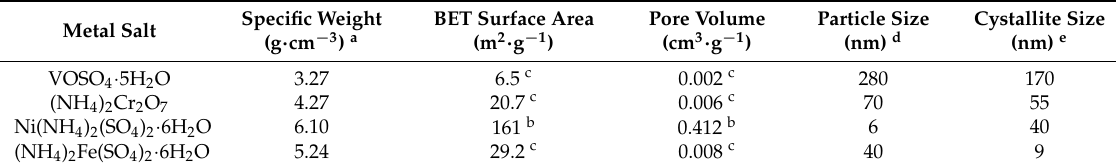
Table 1. Textural properties of nano/micro-oxides prepared by HTC of tannin-metal salts solutions followed by calcination in air.